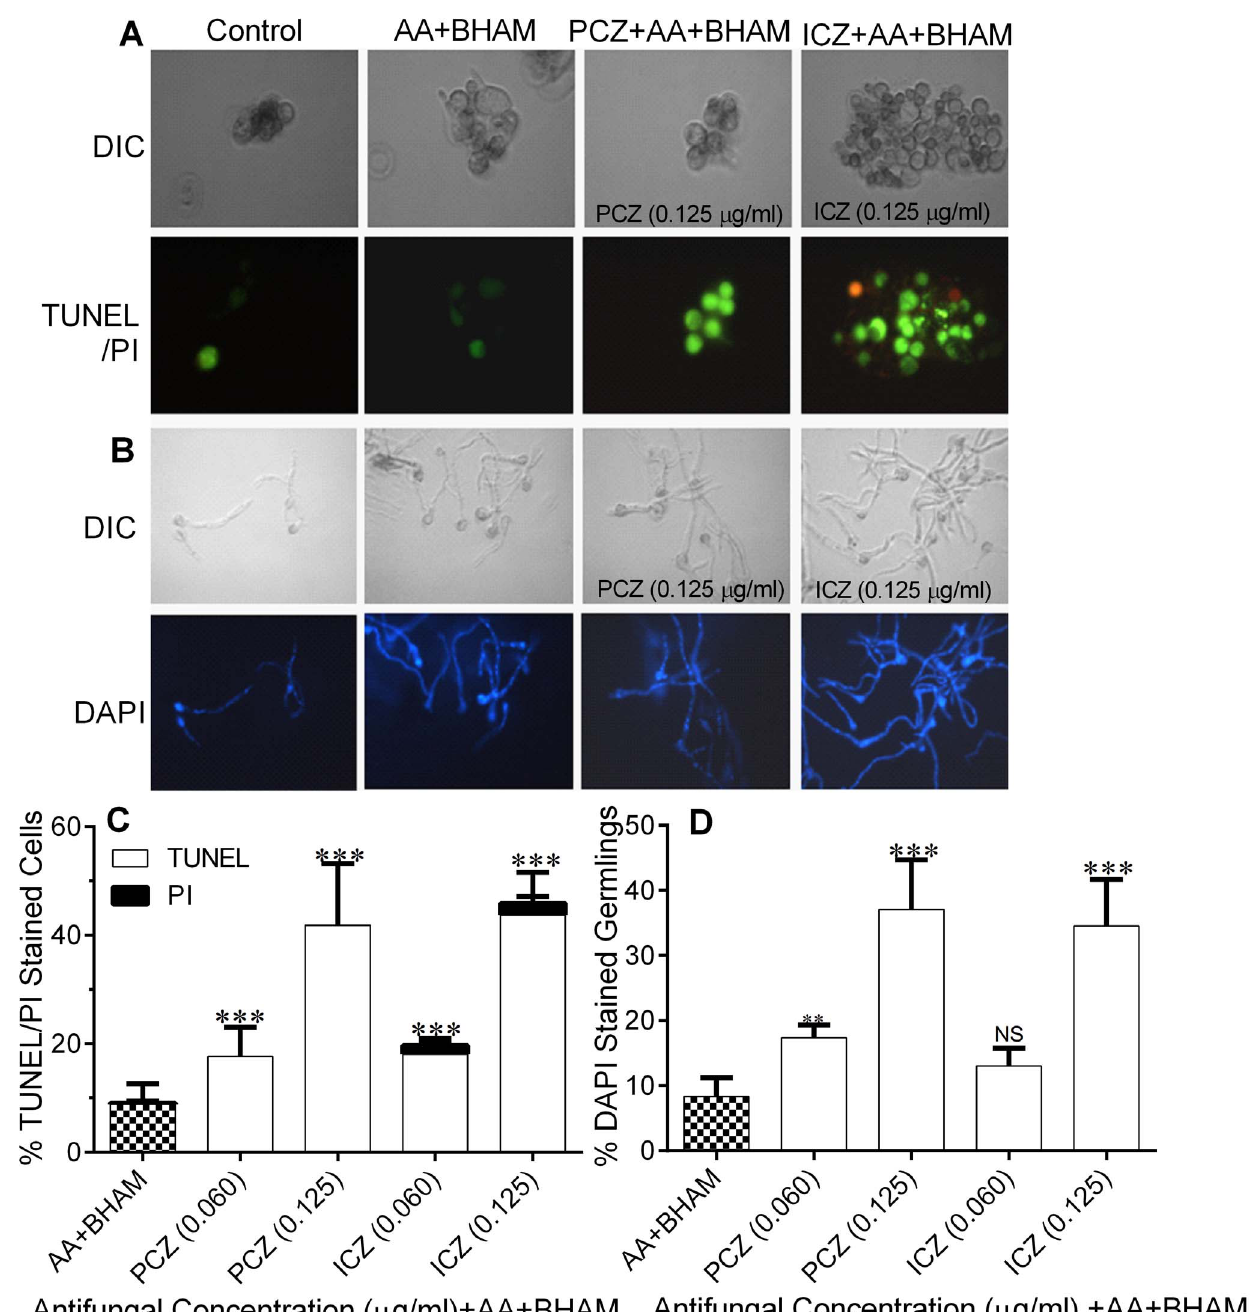
Figure 6. DNA and nuclear fragmentation in R.oryzae germlings treated with PCZ or ICZ in combination with AA and BHAM, germlings treated with only AA and BHAM, and untreated control germlings visualized using fluorescence microscopy. (A) TUNEL/PI staining DNA fragmentation of R. oryzae germlings. (B) DAPI staining of nuclear condensation of R. oryzae germlings. DIC, differential interference contrast. (C and D) Percentages of R. oryzae germlings displaying loss of membrane integrity (PI + ), DNA strand breaks (TUNEL + ), and chromatin condensation (DAPI + ). **, p , 0.001, and ***, p , 0.0001, while NS, p . 0.05, compared to AA + BHAM treated controls.